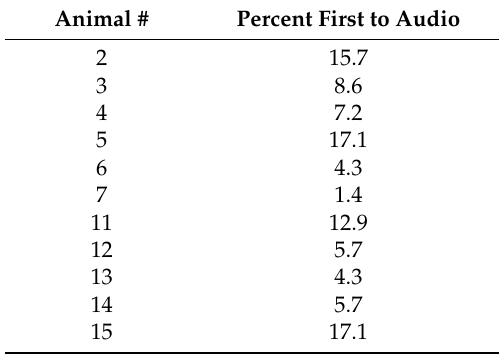
Figure 5. The number of animals that received an audio cue at each separate group of interactions with the virtual fence across a 10-day period of fence activation. Separate groups of interactions by the same or different individuals occurred at least 10 min apart. Table 2. The percentage of total separate groups of fence interactions ( n = 70) in which a specific individual animal was the first to receive an audio cue, i.e., interact with the virtual fence. Animal # Percent First to